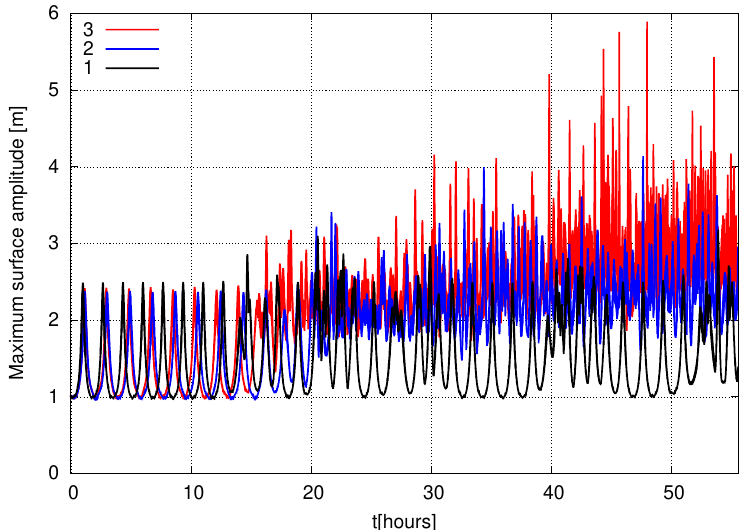
Figure 9. Dependence of maximum surface amplitude on time in three different nonlinear models at µ = 0.04 and ˜ k p = 10. Black solid curve 1 corresponds to the NLS model, blue solid curve 2—to the SCZ equation and red solid curve 3—to the RV equations.